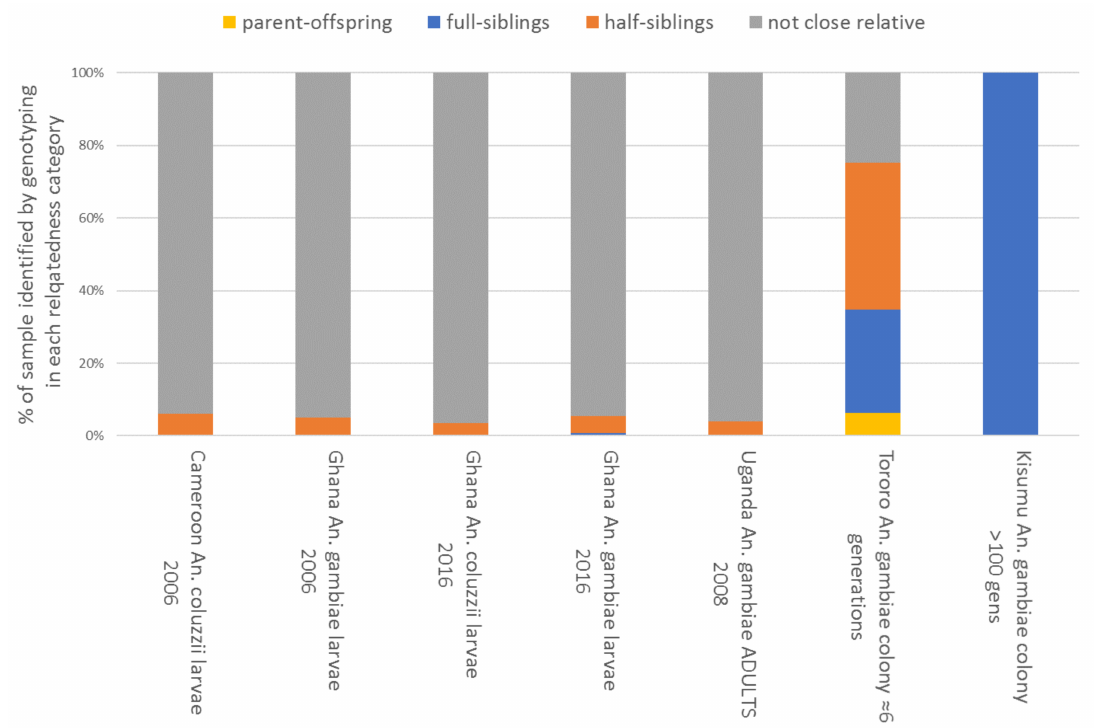
Figure 9. Genotype-based identification of close relatives in female samples collected as larvae from nearby collection locations in 2006 and 2016, and as adults in 2008; samples from both a recently established and a very long term colony are also shown for comparison [40]. Results from 2016 were estimated from data on ≈ 160 samples for each species at 2229 chromosome 3 SNP markers (see Supplementary Material, Figure S8). All other data were from 286 chromosomes 3 SNP markers (37) with field sample sizes of ≈ 180 for adults and 600–700 for larvae. Relationship categories were estimated using ML-Relate